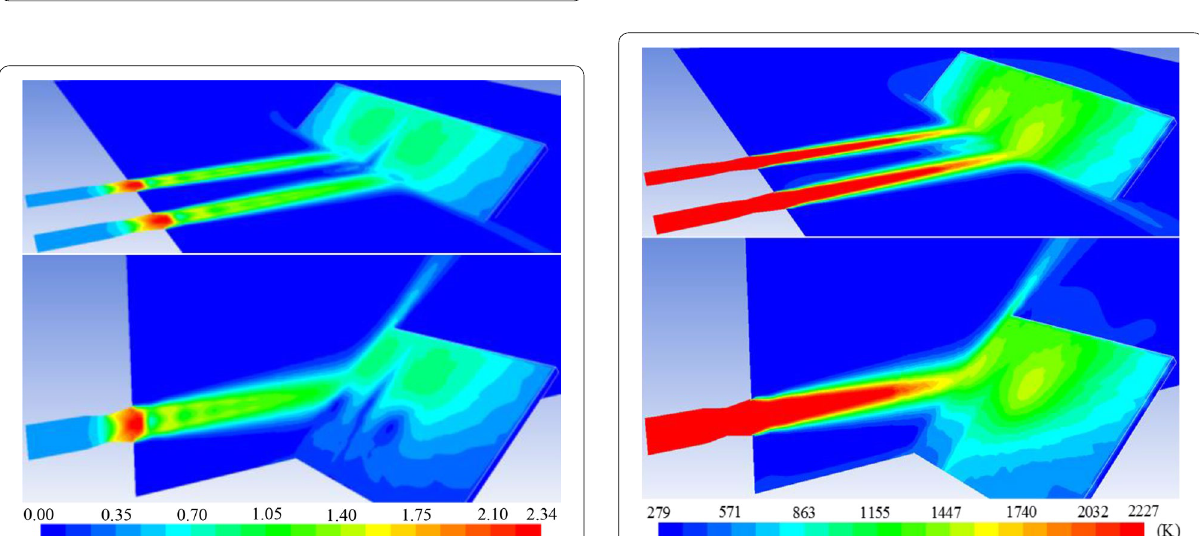
Figure 15 Mach number contour of gas jet from twin engines